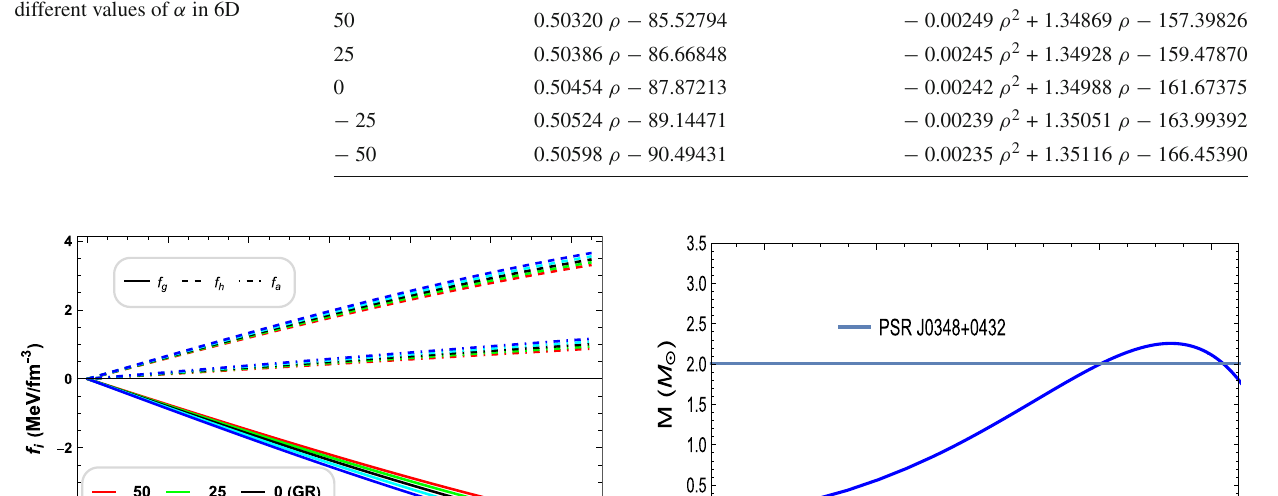
EoS in PSR J0348+0432 for different values of α in 6D